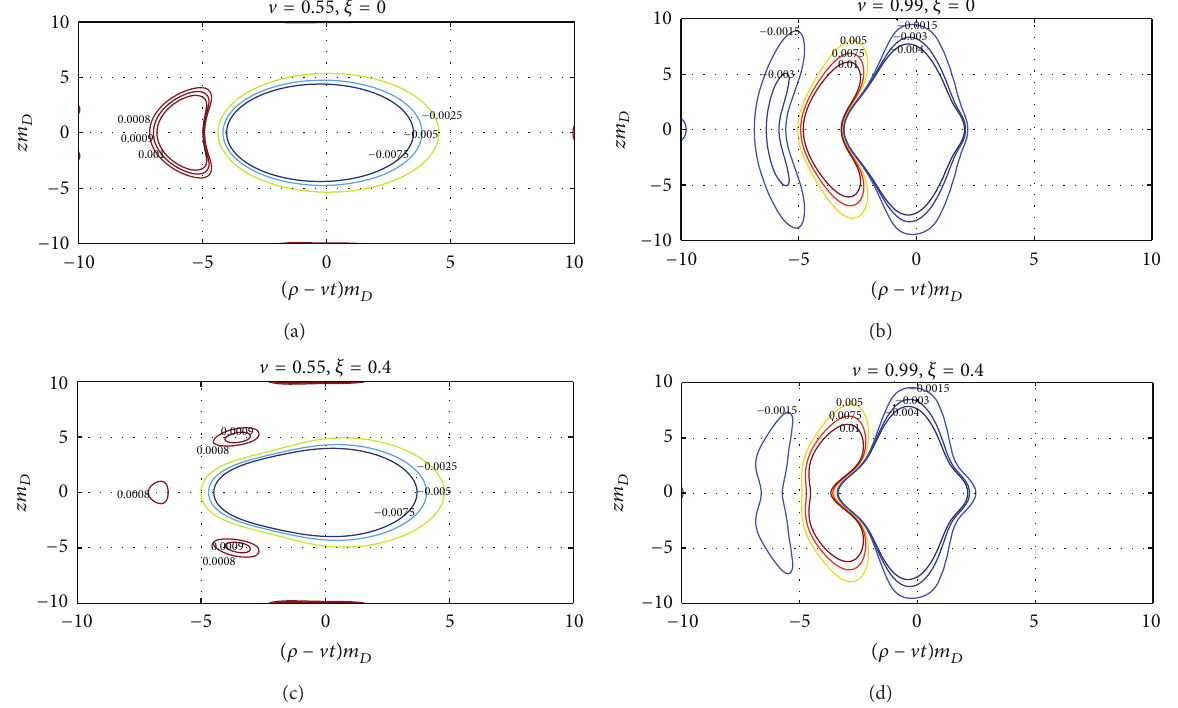
Figure 11: (Color online) The left (right) panel shows the equicharge lines for V = 0.55(0.99) . In this case the parton moves perpendicular to the direction of anisotropy